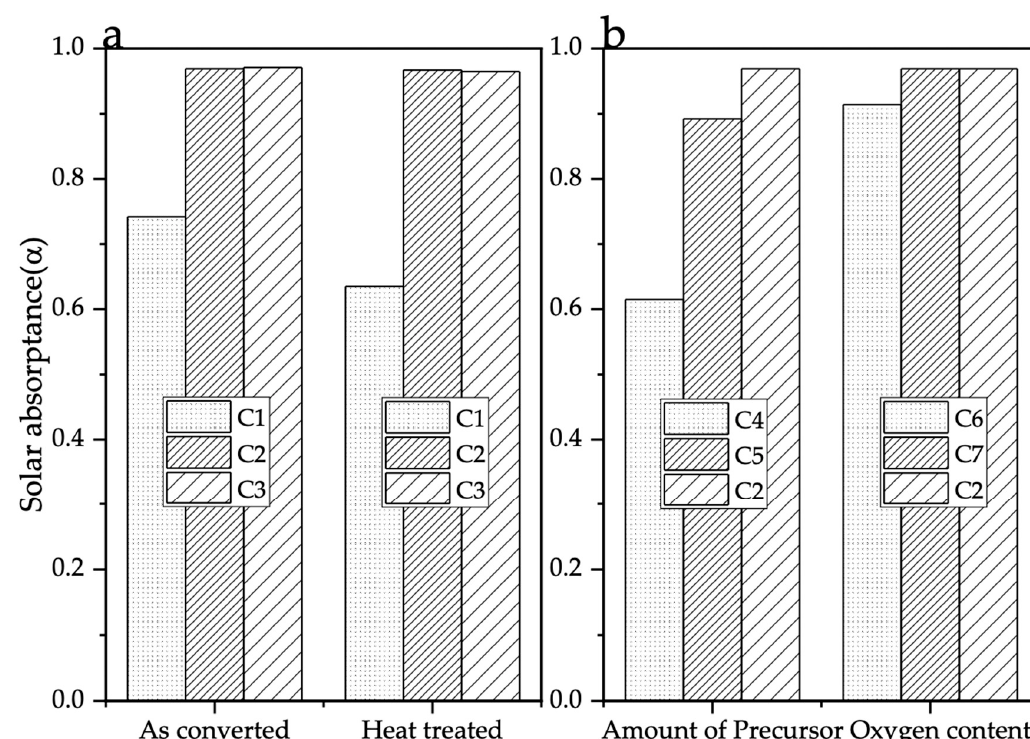
Figure 8. Solar absorptance of coated samples manufactured at different experimental conditions. ( a ) as ‐ converted and heat ‐ treated samples, ( b ) as ‐ converted samples with different precursor amounts and at different O 2 concentrations.